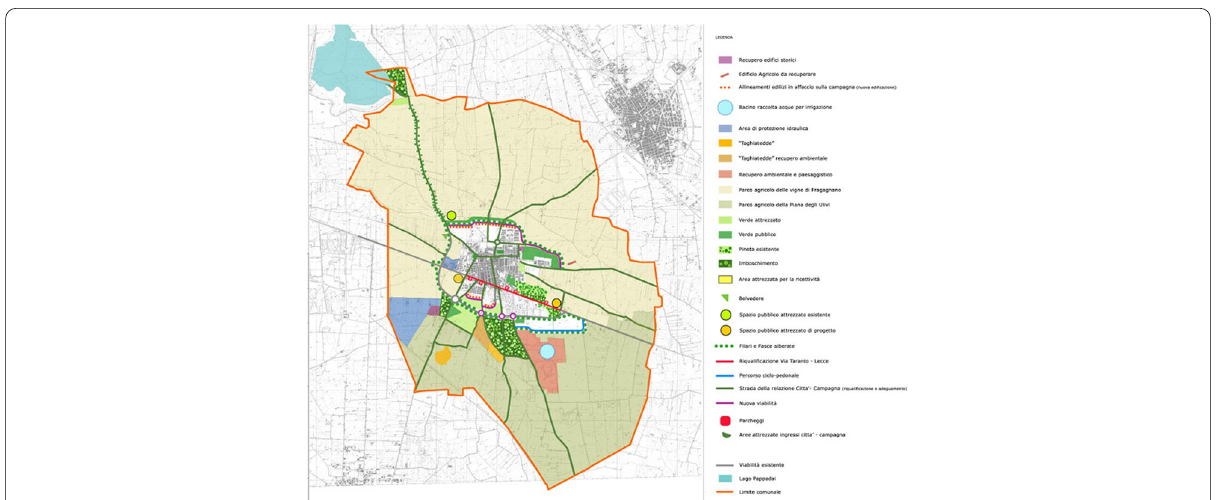
Fig. 7 The City-Country Pact strategy. The City-Country Pact strategy for the small settlement of Fragagnano identifies the peri-urban green belt connected to new green spaces for the redevelopment of abandoned natural areas and old quarry areas. Source: Municipality of Fragagnano, extracts from elaborate 002 (original content scale 1:15,000, north–south oriented) of the Adaptation of the Municipal Plan to the PPTR